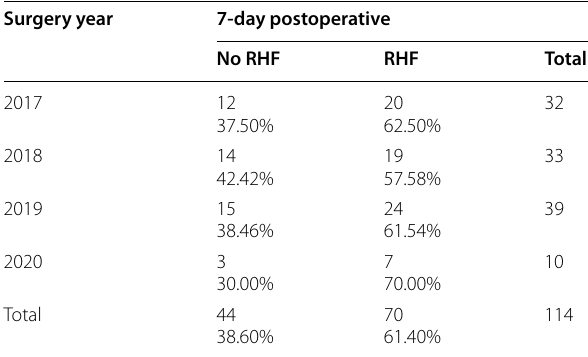
Table 1 Incidence of postoperative RHF in patients undergoing